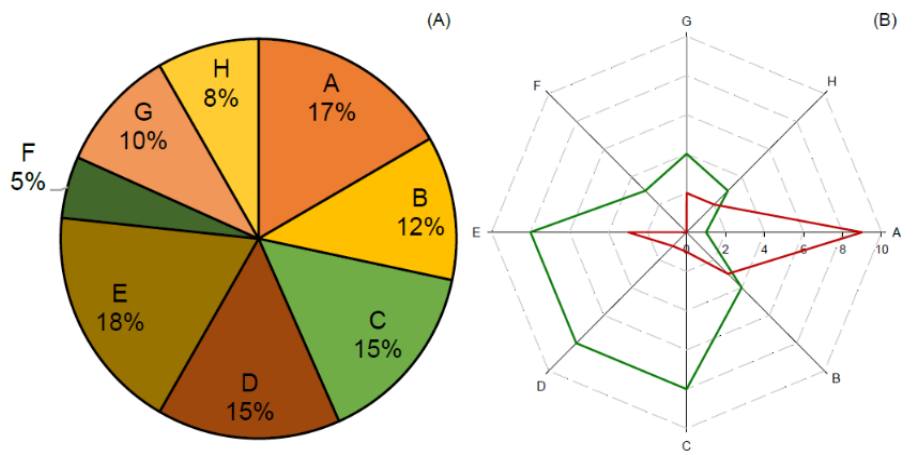
Figure 4. Results of the primary screening hits. Hits distribution (%) among the different cyanobacteria crude extract fractions, from A to H, corresponding A to the most polar fraction and H to the least polar ( A ). The number of hits causing repression [fold induction (FI) ≤ 0.5; red line] or induction (FI ≥ 2; green line) on PPARs activity ( B ).